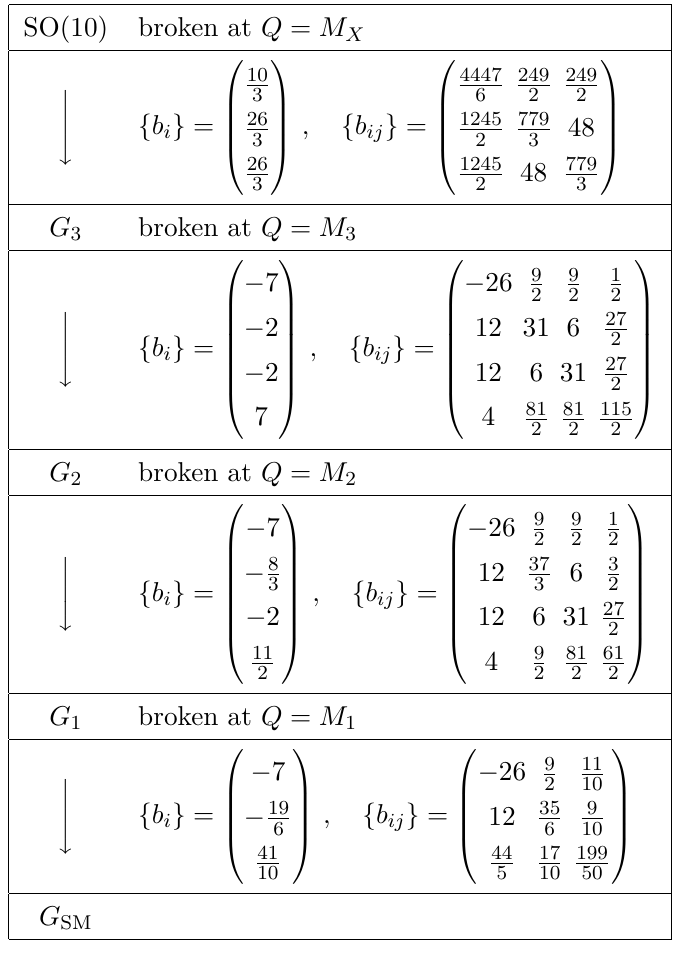
Table 5 . Coefficients b i and b ij of gauge coupling β functions appearing in the specified breaking